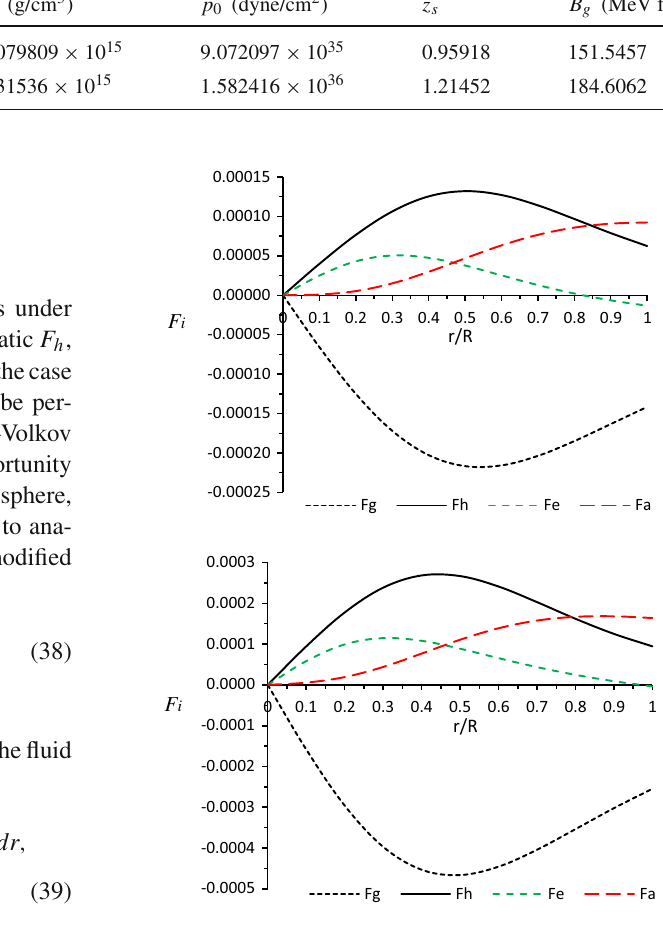
Table 2 The central density ( ρ 0 ), surface density ( ρ s ), central pressure ( p 0 ), surface redshift ( z s ) and bag constant ( B g ) for Strange star candidates Strange stars candidates